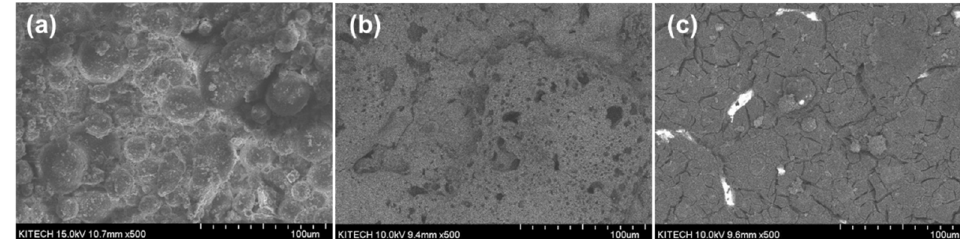
Figure 4. Surface SEM image of powder bed 3D printed molded body after ( a ) printing (G sample) ( b ) colloidal silica treatment (GC sample) ( c ) after final heat treatment (GCH sample).